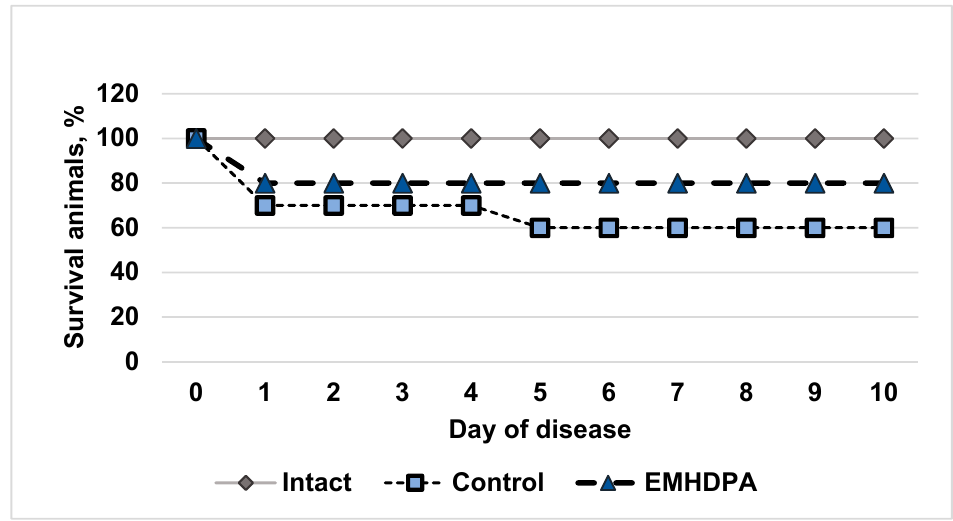
Figure 1. Effect of the studied drugs on rat survival in simulated pneumococcal meningitis in the experiment, %. 1—intact group; 2—control group; 3—group administered with EMHDPA 25 mg/kg.